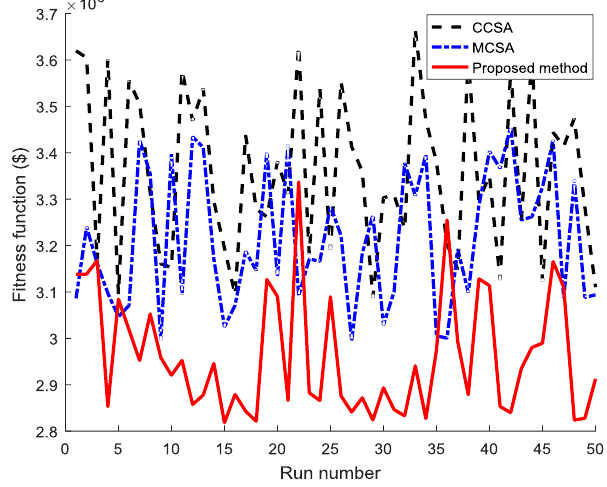
Figure 6. Fitness function values obtained by CCSA, MCSA, and the proposed method over 50 runs for the IEEE 118 buses system.